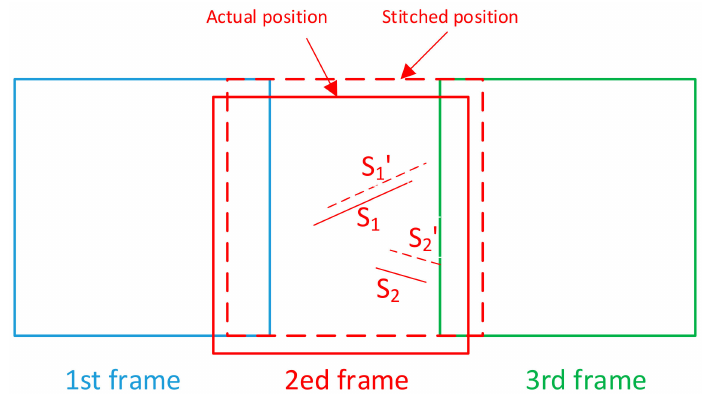
Figure 7. Location deviation of defects caused by sub-apertures with no feature in the overlapping area by the conventional method.